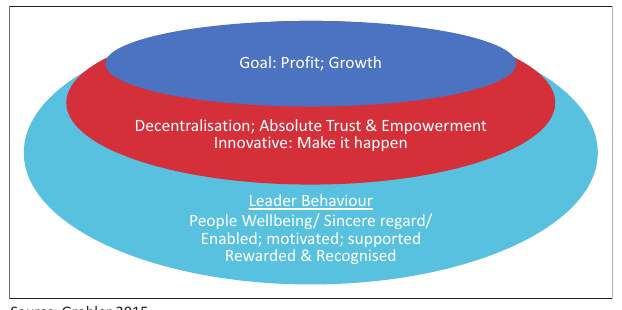
FIGURE 6: Simplicity of the group’s philosophy on the macro-, meso-, and micro-